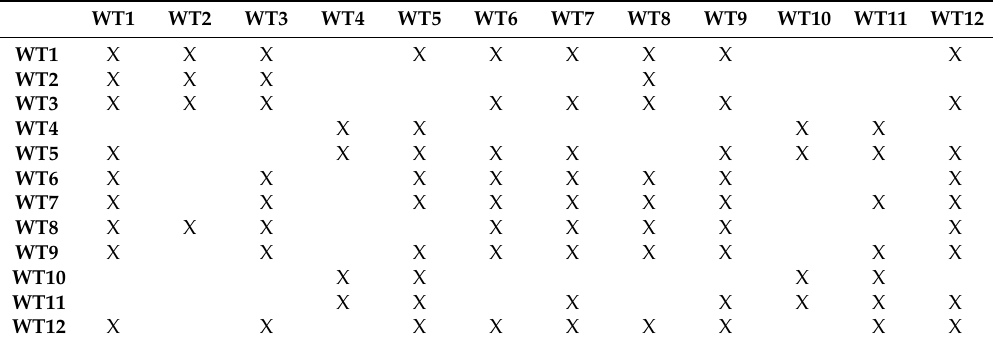
Table 3. Pairs of wind turbines (WTs) that did not have a significantly different power performance at the α “ 0.01 significance